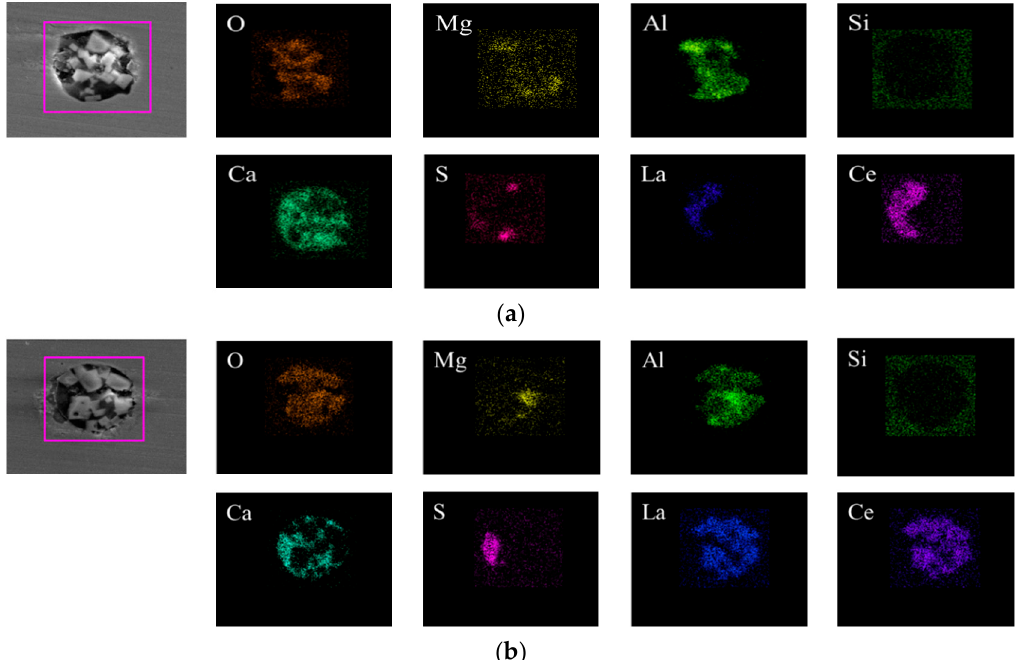
Figure 9. Surface scanning results for inclusions in the tundish pouring zone. ( a ) (La, Ce)Al 2 O 3 +MgO-Al 2 O 3 -CaO, ( b ) (La, Ce)Al 2 O 3 +CaS-Al 2 O 3 -CaO.